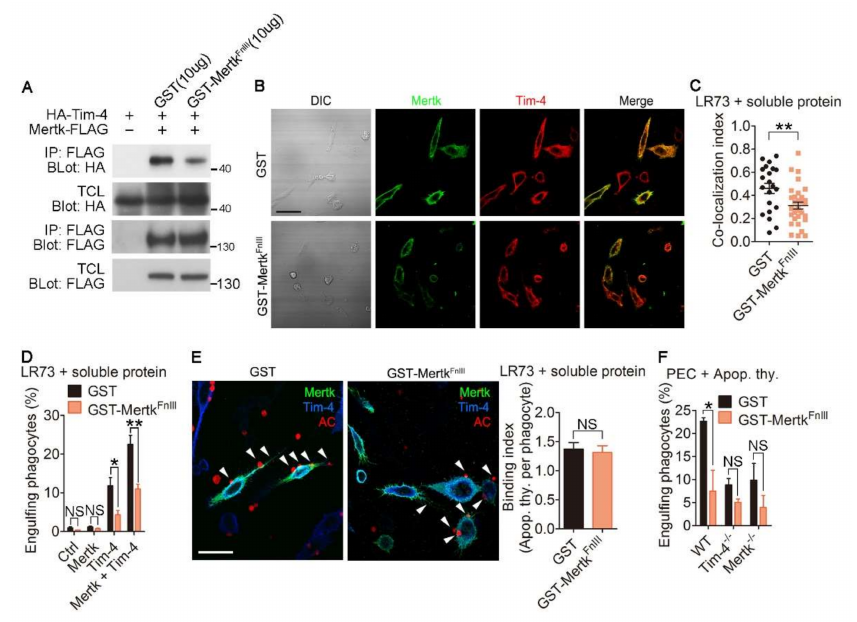
Figure 4. Disrupting interaction of Tim-4 with Mertk abolishes the synergistic e ff ect of Mertk on Tim-4-mediated e ff erocytosis. ( A ) The lysates of 293T cells transfected with the indicated plasmids were incubated with anti-FLAG antibody-conjugated agarose beads in the presence of purified GST-Mertk FnIII or GST. Bound proteins on the beads were detected by immunoblotting ( n = 3). ( B , C ) LR73 cells were transfected with HA-Tim-4 and Mertk-FLAG. One day after transfection, the cells were incubated with purified GST-Mertk FnIII or GST for 2 h, stained with anti-Mer and anti-HA antibodies, and labeled with Alexa Fluor 488- and Alexa Fluor 594-conjugated secondary antibodies. Images were acquired by confocal microscopy (( B ), n = 2) and bound apoptotic cells were counted (( C ), n ≥ 21 cells). Scale bar, 20 µ m. ( D ) LR73 cells transfected with the indicated plasmids were incubated with TAMRA-labeled apoptotic thymocytes in serum-free alpha-MEM for 2 h in the presence of purified GST-Mertk FnIII or GST, washed with PBS, trypsinized, and analyzed using flow cytometry ( n = 4). ( E ) LR73 cells were transfected with HA-Tim-4 and Mertk-FLAG. One day after transfection, the cells were incubated with TAMRA-labeled apoptotic thymocytes in serum-free alpha-MEM at 4 ◦ C for 2 h, washed, fixed, stained with anti-Mer and anti-HA antibodies, and labeled with Alexa Fluor 488- and Alexa Fluor 405-conjugated secondary antibodies ( n ≥ 100 cells). Arrowheads indicate bound apoptotic cells. AC, apoptotic cells. Scale bar, 20 µ m. ( F ) Peritoneal macrophages derived from WT , Tim-4 - / - , or Mertk - / - were incubated with TAMRA-labeled apoptotic thymocytes in serum-free RPMI for 2 h in the presence of purified GST-Mertk FnIII or GST, and then peritoneal macrophages engulfing apoptotic thymocytes were analyzed using flow cytometry ( n = 4). Data are shown as the mean ± standard deviation. NS, not significant. ** p < 0.01, * p < 0.05. TCL, total cell lysate; IP,